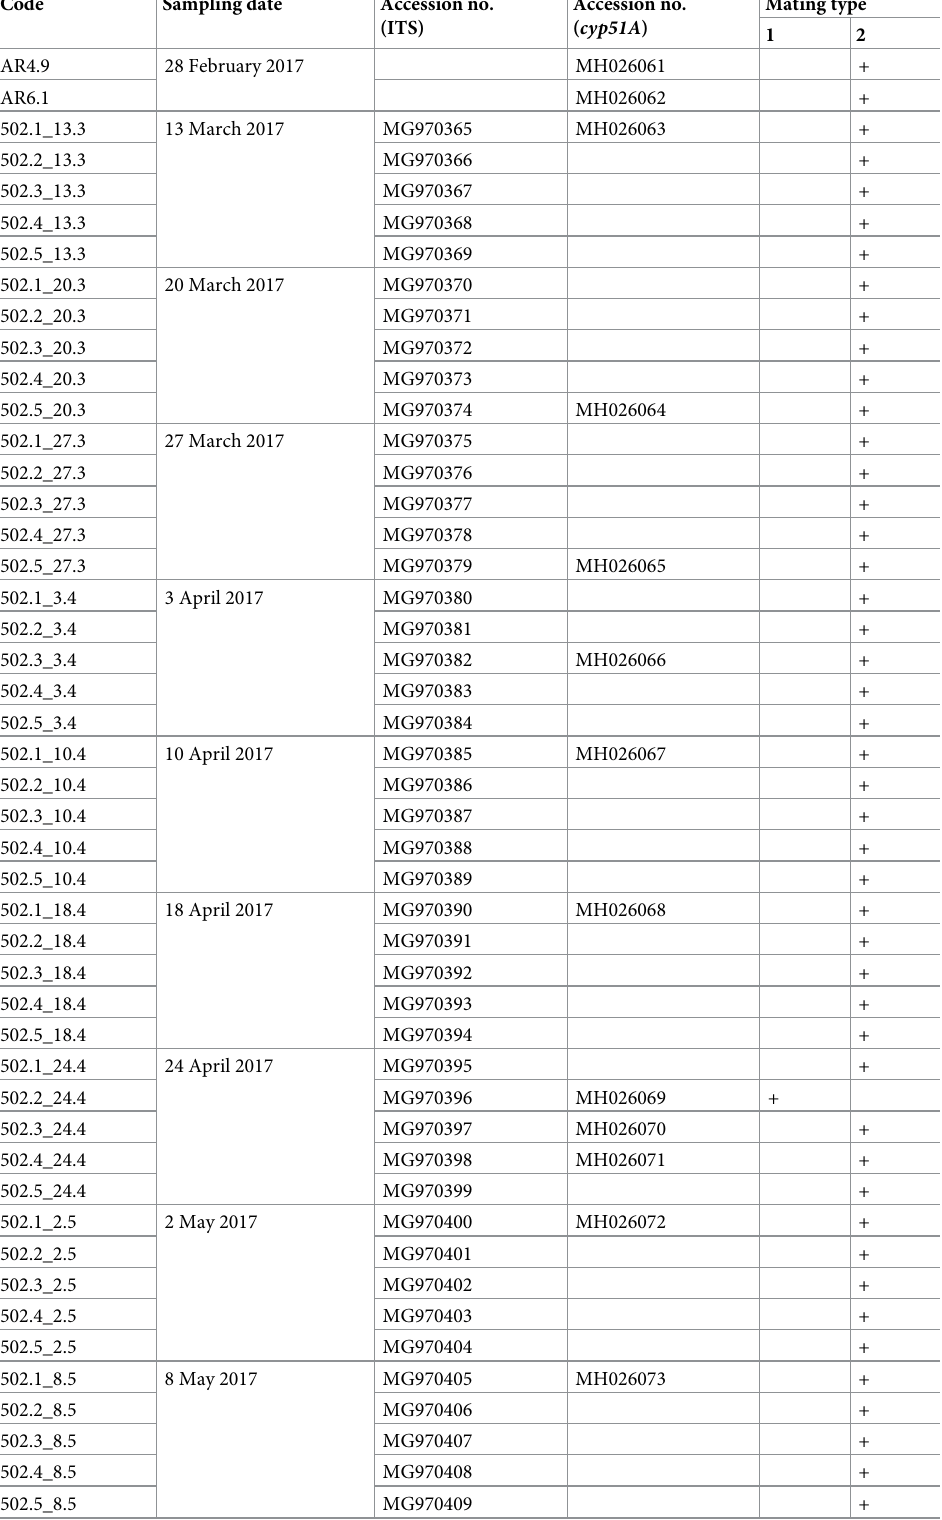
Table 1. List of A . fumigatus isolates selected for sensitivity assays with accession numbers and mating